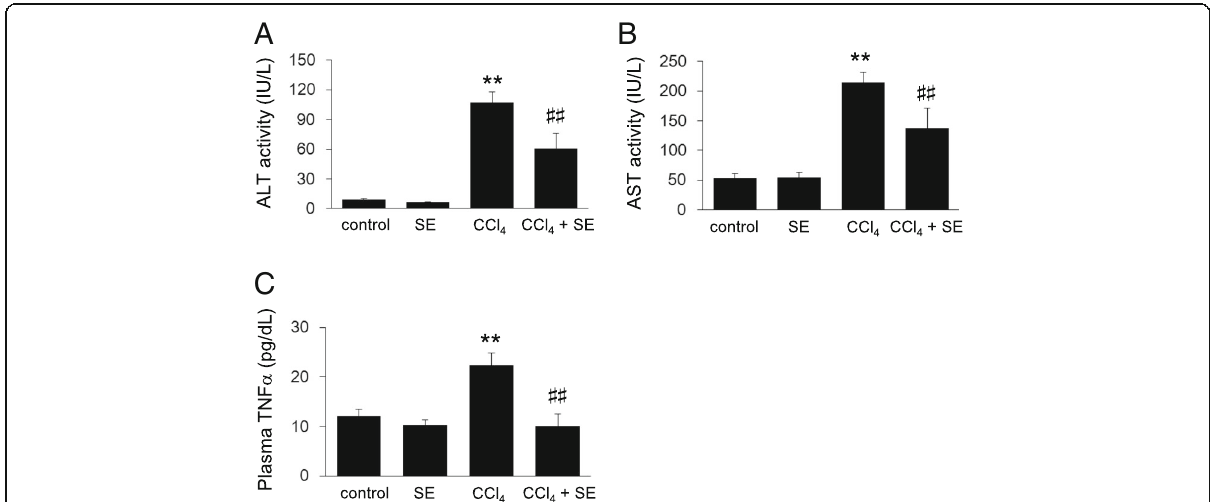
Fig. 3 Effect of SE on levels of hepatic injury markers and inflammatory cytokines. Animals treated as described in Fig. 2 were euthanized 72 h post intraperitoneal injection and plasma levels of hepatic injury markers, and inflammatory cytokines were determined. Panels a , b , and c indicate ALT, AST, and TNF α , respectively. Data are plotted as mean ± SD for groups of 6 mice each. ** indicates p < 0.01 versus control group, and ## indicates p < 0.01 versus CCl 4 group.